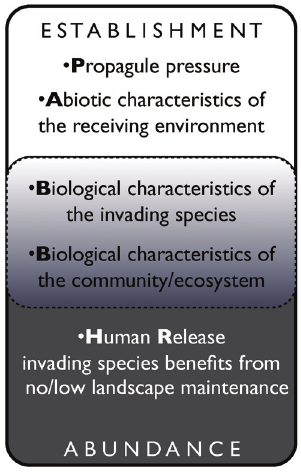
Figure 1. Incorporating our hypothesis into the PAB framework. The establishment and abundance of invasive plant species are explained by different mechanisms, which have been summarized by Catford et al. (2009) 16 in the PAB framework (see text for details). However, the biological characteristics of a given invading species and of its new environment only partly explain the abundance of established invasive populations. We argue that additional insights can be gained via the Human Release Hypotheses, which can complement the existing PAB